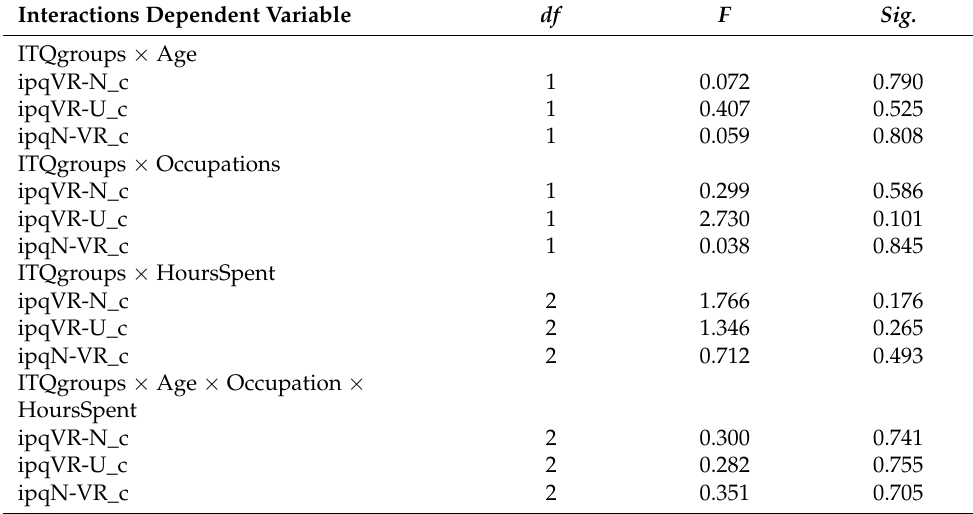
Table 4. Homogeneity of regression